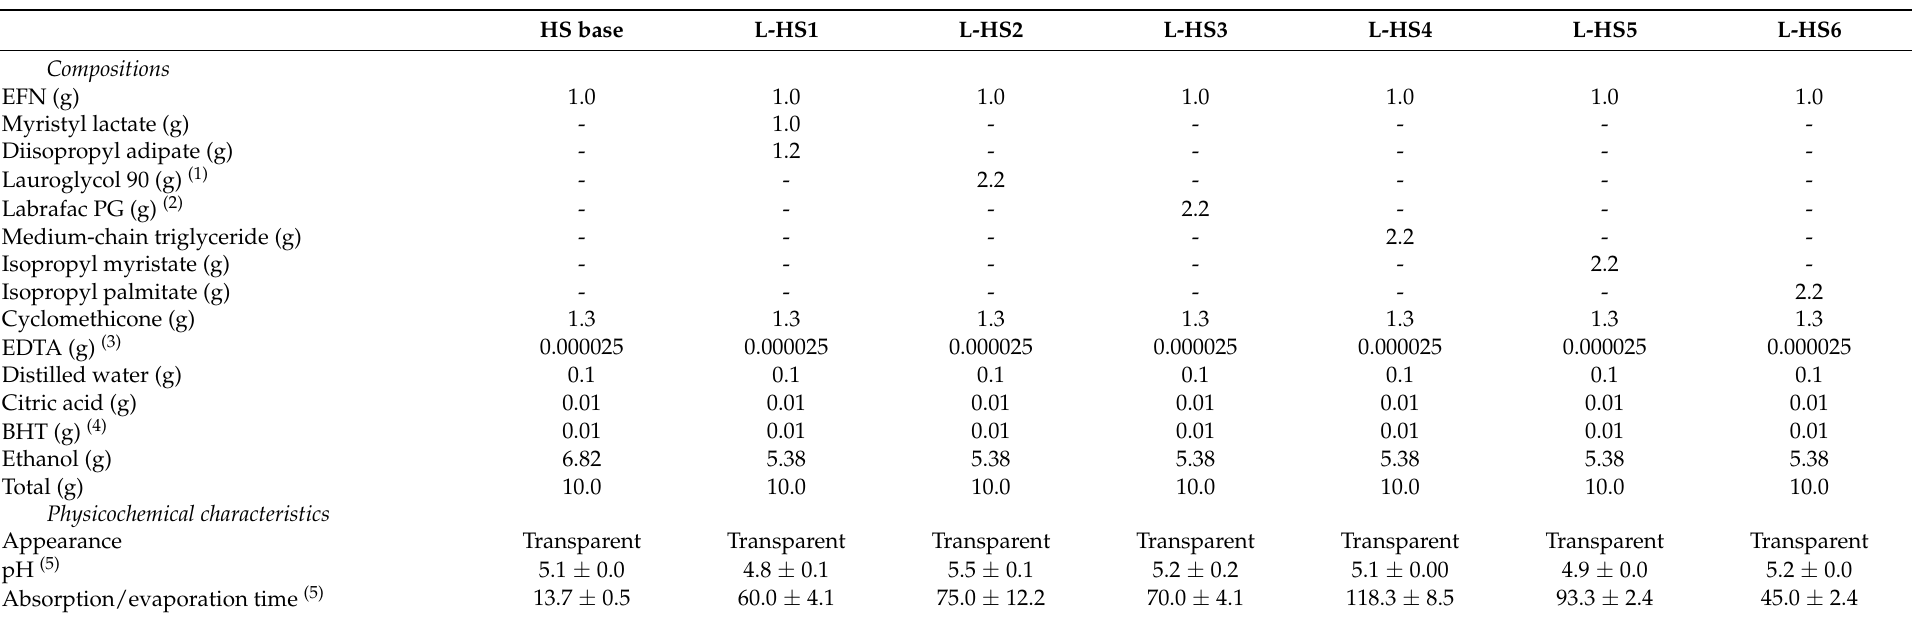
Table 1. Compositions and physicochemical characteristics of efinaconazole (EFN)-loaded hydroalcoholic solutions (HSs) with different lipophilic permeation